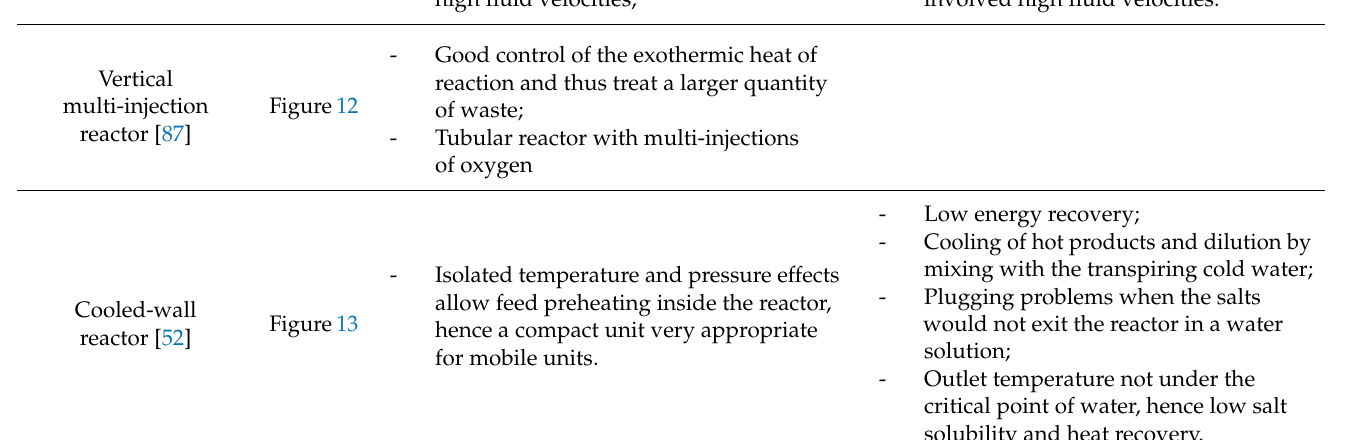
- High heat losses due to the temperature gradient between the top and bottom of the reactor; - A Difficult continuous salts recovery; - Highly corrosive brine, accumulating at the bottom of the reactor - Dilution of the hot reaction products by mixing with the transpiring water; - Less efficient heat recovery due to reduced reactor effluent temperature. - Important Length to achieve residence times greater than one minute due to involved high fluid velocities. - Low energy recovery; - Cooling of hot products and dilution by mixing with the transpiring cold water; - Plugging problems when the salts would not exit the reactor in a water solution; - Outlet temperature not under the critical point of water, hence low salt solubility and heat